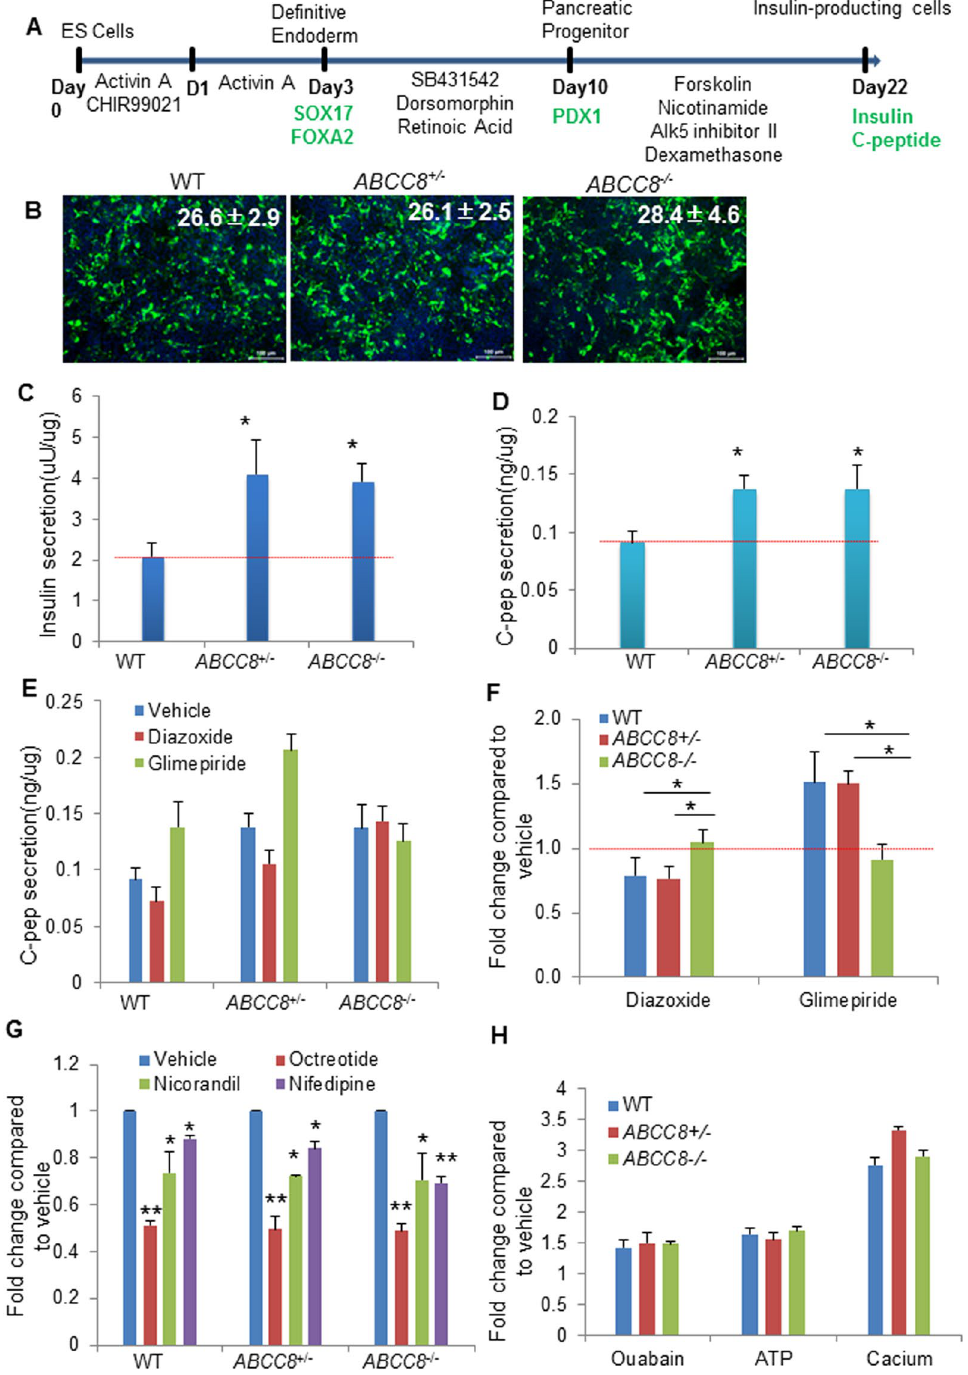
Figure 1. ABCC8 -deficient insulin-producing cells exhibited greater insulin secretion and insulin secretion responses to the various stimulations. ( A ) Schematic of directed differentiation from pluripotent stem cells to insulin-producing cells via the small molecule-based method. ( B ) Immunofluorescence for insulin at the final stage of differentiation. ABCC8 -deficient cells demonstrated similar differentiation efficiency as wild-type cells. ( C ) ELISA analysis for insulin content in the supernatant. ABCC8 -deficient cells demonstrated greater insulin secretion than wild-type cells. ( D ) ELISA analysis for C-peptide content in the supernatant. ABCC8 -deficient cells demonstrated greater C-peptide secretion than wild-type cells. ( E ) ELISA analysis for C-peptide levels in the presence of vehicle, diazoxide and glimepiride. ( F ) The fold change of C-peptide content after diazoxide and glimepiride stimulation. Diazoxide and glimepiride decreased and increased C-peptide secretion in wild-type and heterozygous mutated cells, respectively. Neither diazoxide nor glimepiride had an effect on homozygous mutated cells. ( G ) The fold change of C-peptide content after octreotide, nicorandil and nifedipine treatment. Octreotide, nicorandil and nifedipine decreased insulin secretion in wild-type, heterozygous mutated and homozygous mutated cells. ( H ) The fold change of C-peptide content after ouabain, extracellular ATP and calcium chloride